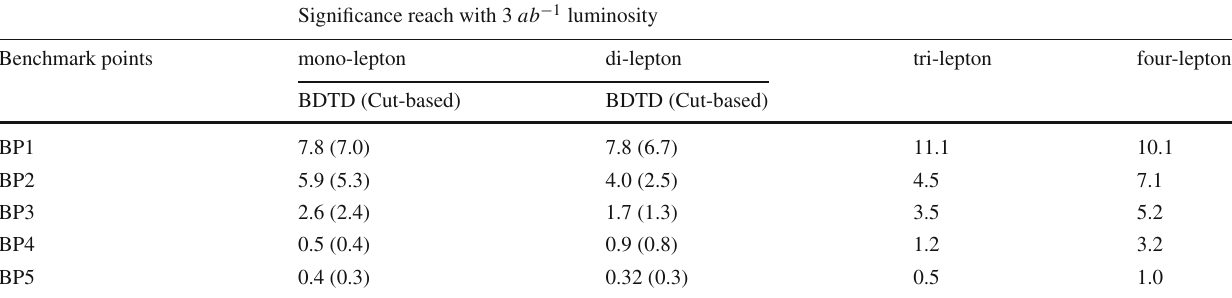
Table 17 Significance reach with 3 ab − 1 luminosity for all the five benchmark points for mono-lepton, di-lepton, tri-lepton and four lepton channel